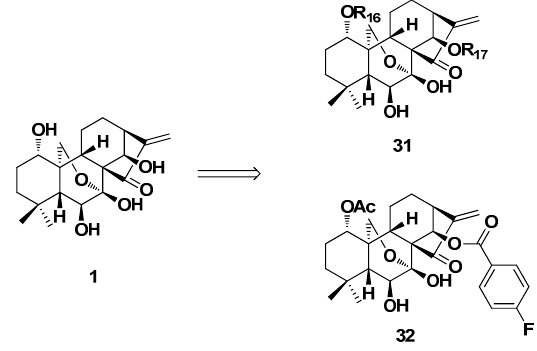
Figure 15. The 1- or/and 14-position modified oridonin derivatives ( 31 and 32 ) with antibacterial activity.